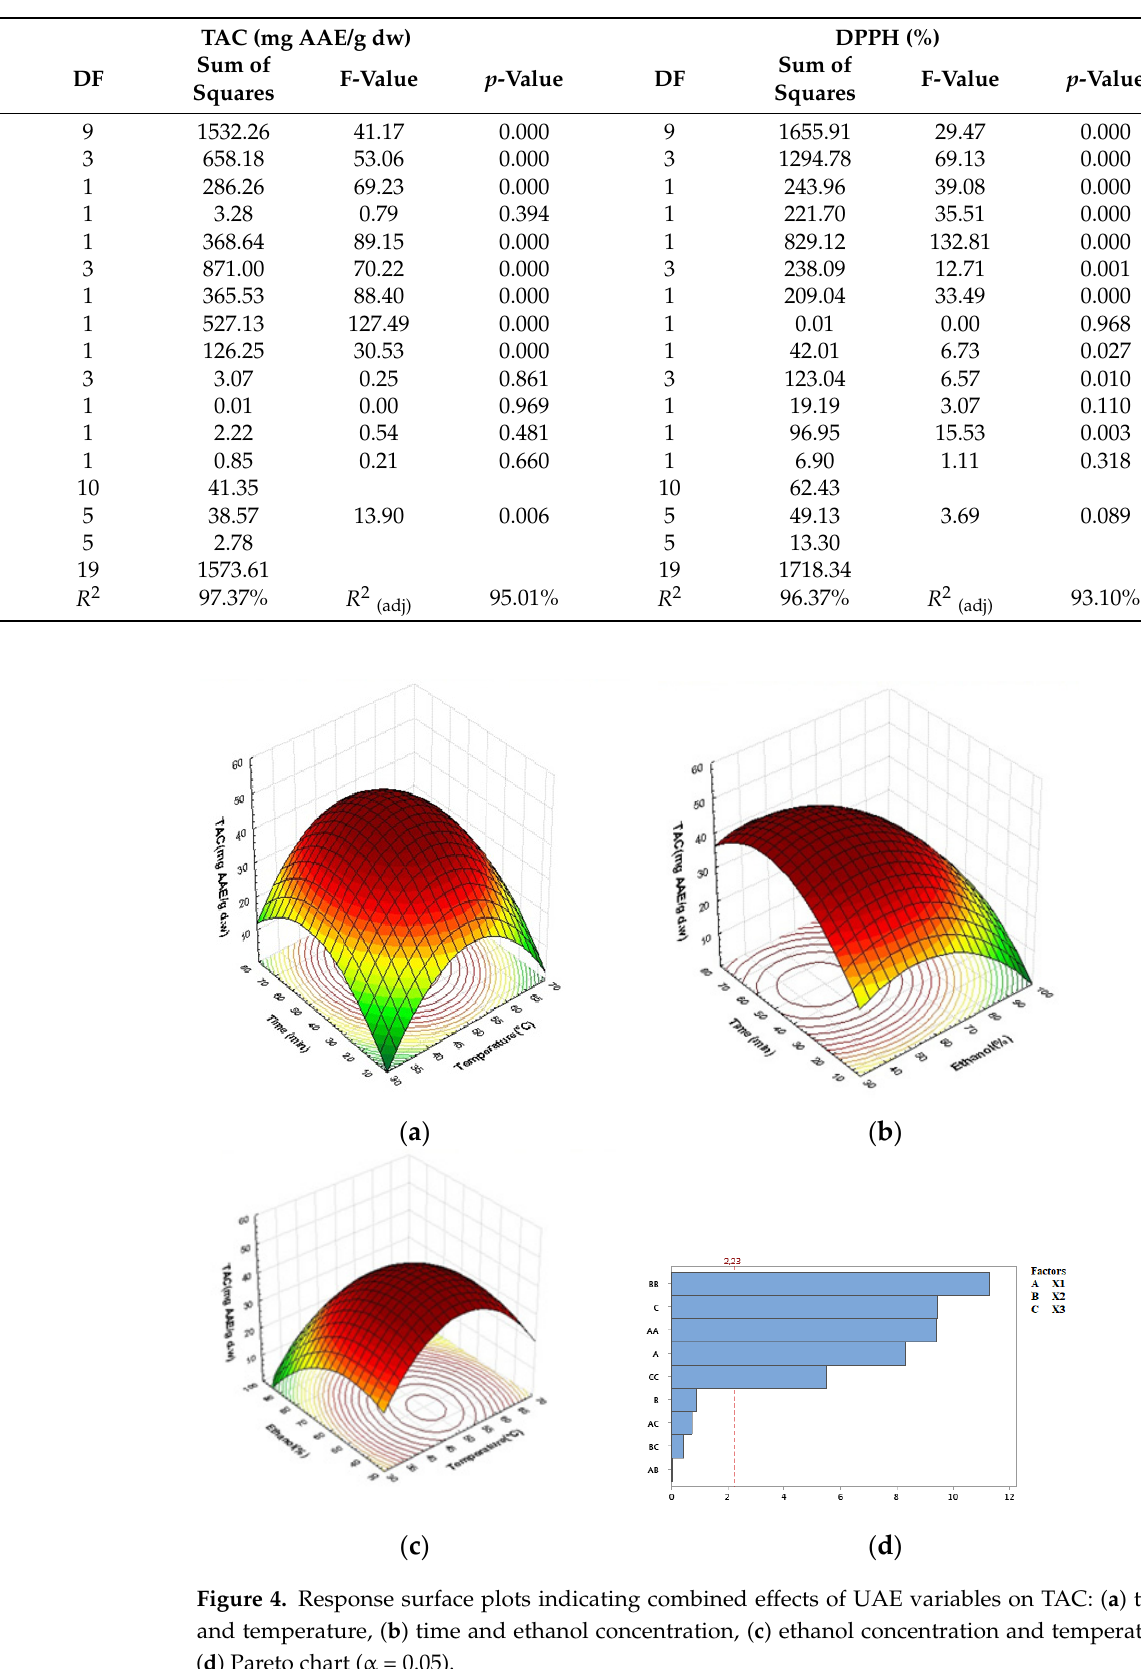
X (cid:2869) (cid:2870) (2)